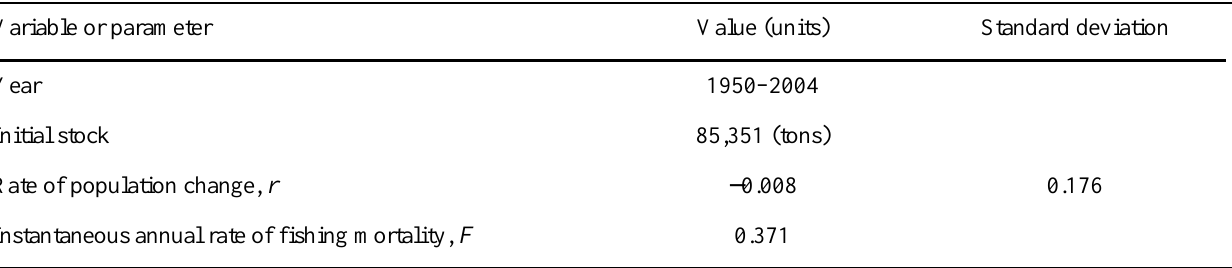
Table 3. Values of variables and parameters used to simulate blue crab stock and landings in hindcast